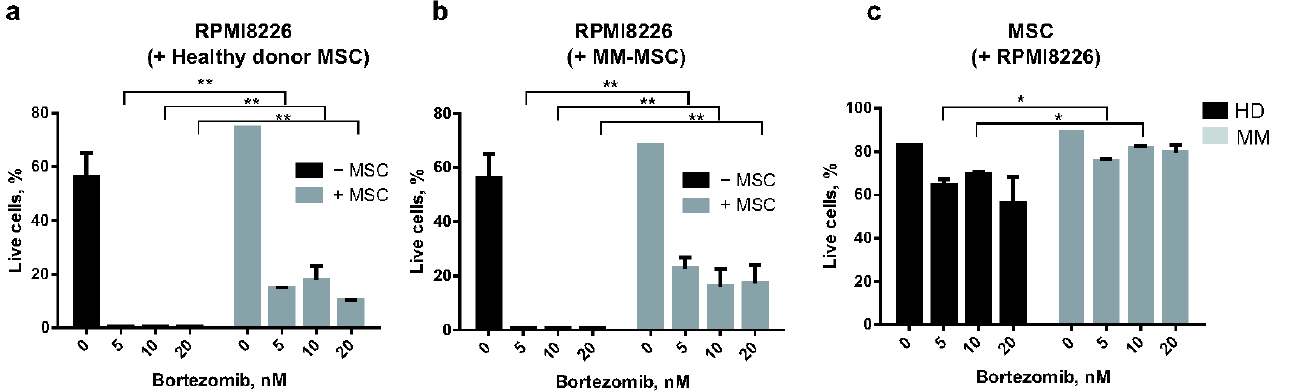
Figure 2. MSC from HD ( a ) or MM patients ( b ) supported the survival of MM cells of RPMI8226 cell line during treatment with bortezomib, a standard medication to treat MM. RPMI8226 were grown in non-contact co-culture with HD-MSC or MM-MSC in the presence of bortezomib for 48 h. Then, RPMI8226 ( a , b ) and MSC ( c ) were harvested, stained with annexin-FITC and propidium iodide and subjected to flow cytometry to reveal live and apoptotic cells. X -axis—bortezomib concentration, nM; Y -axis—the percentage of live cells defined as cells negatively stained with both annexin and propidium iodide. ** p < 0.01, * p < 0.05. Abbreviations: MSC = mesenchymal stem cells; HD-MSC =